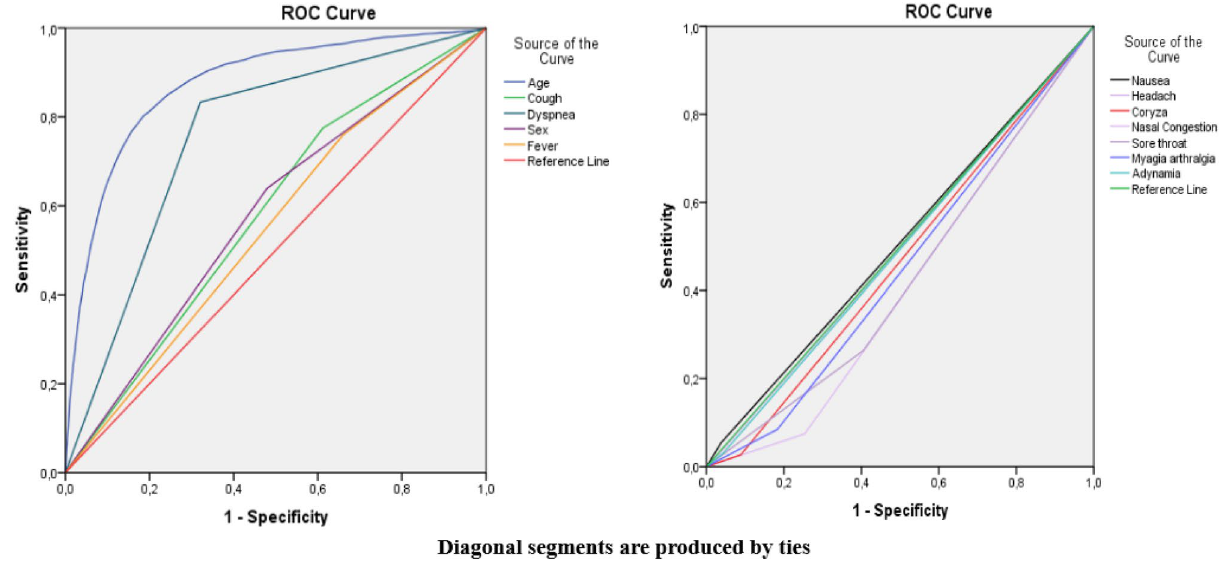
Figure 4. ROC curves of age, dyspnea, cough, sex, fever, nausea, nasal congestion, adynamia, coryza, myalgia, arthralgia, sore throat, headache, and logistic regression model in patients with COVID-19. Source: OpenDataSUS, Ministry of Health.